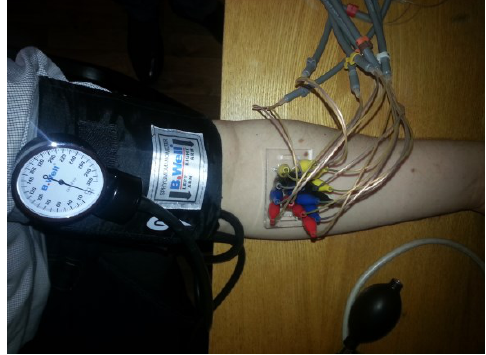
Fig. 4: The method of peripheral vein localization.